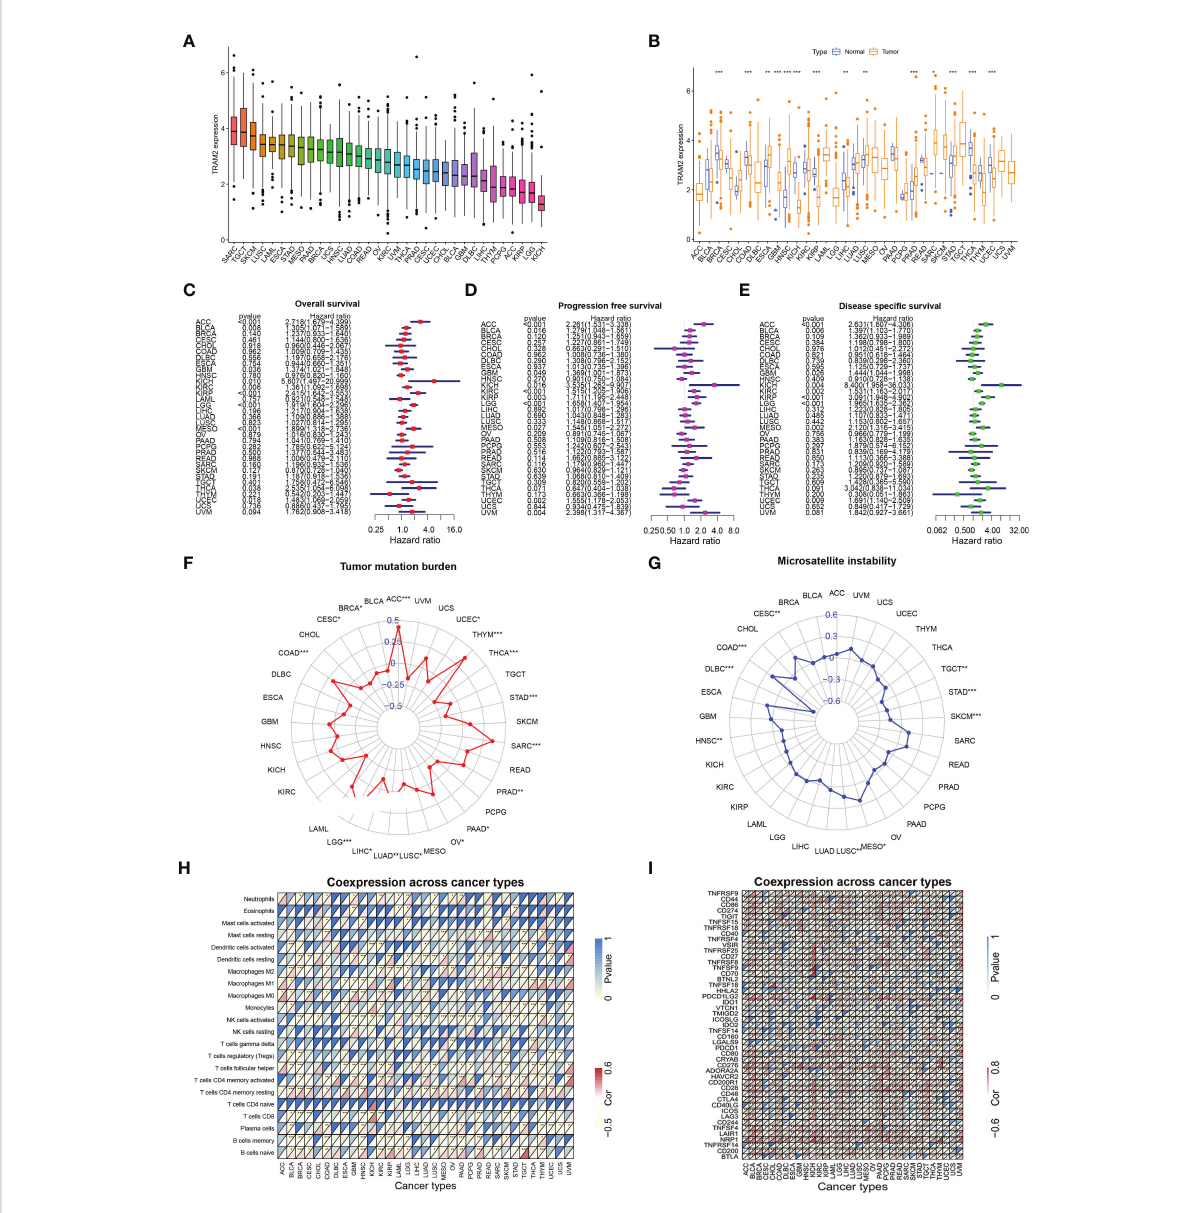
FIGURE 9 Analysis of TRAM2 in pan-cancer. (A) Expression of TRAM2 in 33 cancers. (B) Expression of TRAM2 in tumor and normal tissue in pan-cancer. (C) Overall survival of TRAM2 in pan-cancer. (D) Progression free survival of TRAM2 in pan-cancer. (E) Disease speci fi c survival of TRAM2 in pan- cancer. (F) Tumor mutation burden of TRAM2 in pan-cancer. (G) Microsatellite instability of TRAM2 in pan-cancer. (H) Co-expression analysis of TRAM2 and immune cells in pan-cancer. (I) Co-expression analysis of TRAM2 and immune checkpoints in pan-cancer. *P < 0.05, **P < 0.01, ***P <